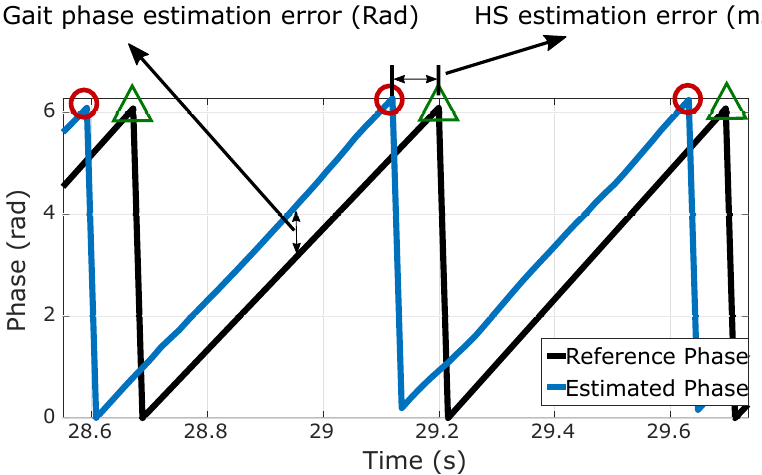
Figure 8. Gait phase estimation error and Heel Strike (HS) estimation error (red circles = estimated HS; green triangles = HS detected by pressure sensor).